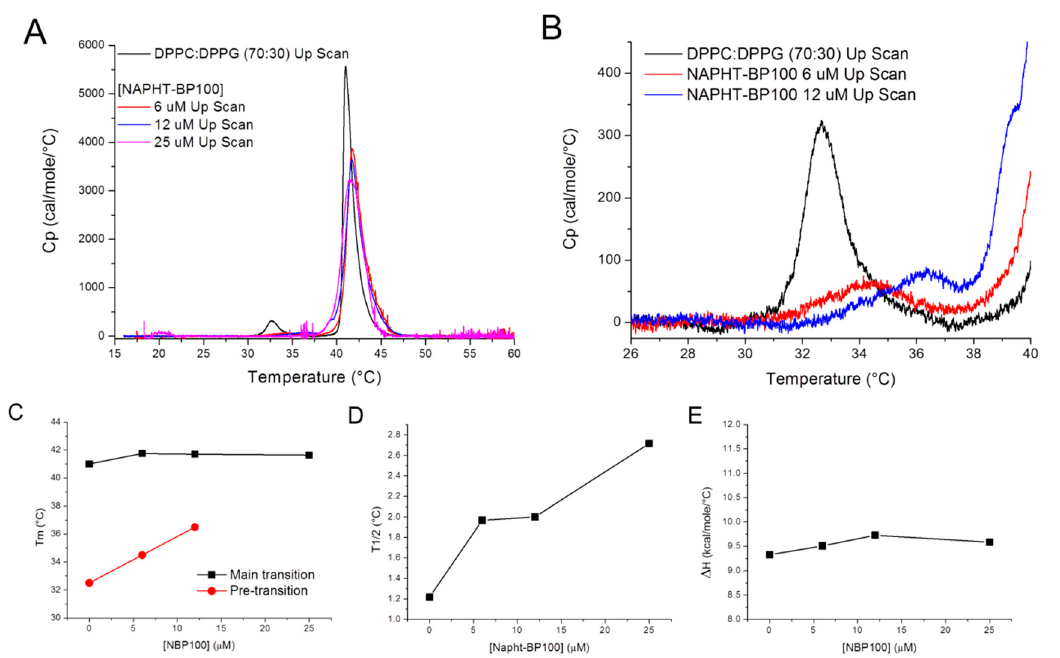
Figure 8. NAPHT-BP100 effects on lipid organization. Lipid concentration was 1.0 mM in 10 mM Tris-HCl buffer, pH 7.4. ( A ) Differential scanning calorimetry heating scans of DPPC:DPPG (70:30, mol:mol) multilamellar vesicle (MLV) in solution and with of various NAPHT-BP100 concentrations. ( B ) Expanded scale heating scans. ( C ) Main and prephase transition